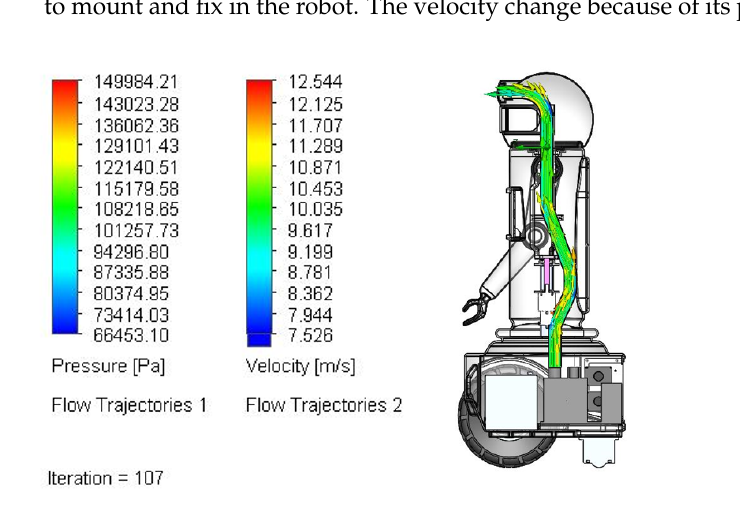
Figure 17. Schematic of experiment and the airflow display simulation. (SectionA-A). The present work discusses the characteristics of the skin sensation evoked by the airflow to the shopper during their shopping in an outdoor market. The effect of the cool air increases the degree of comfort of the shopper. The equivalent speed of airflow for the user is 28 CFM, which is lowered from the airflow speed of their actual walk. The airflow is produced on the user’s back by an air conditioner of 450 W with a gap distance of around 1000 mm as shown in Figure 18. The airflow speed is 28.3 CFM (1.63 m/s), which is approximately less than the actual walk speed of the user. The result proposes that the sensation of airflow is suppressed while the movement is performed actively with visual information provided. In this test, two factors—the skin and the vestibular system—are taken into consideration. We fix the airflow to 0.14 m/s at each trial to cancel the perceptual hysteresis in the equality adjustment experiment. The airflow is optimized beforehand to provide a comfortable shopping experience.